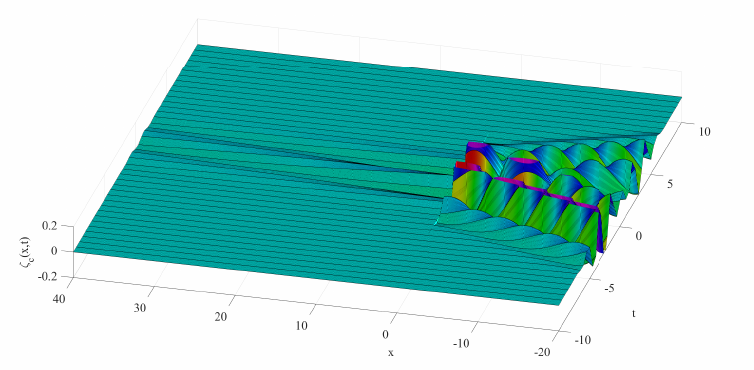
Figure 16. Variation of the free surface displacement ζ c ( x , t ) (m) versus x (m) and time t (s) in the case of a semi infinite plate in the case of flat seabed.